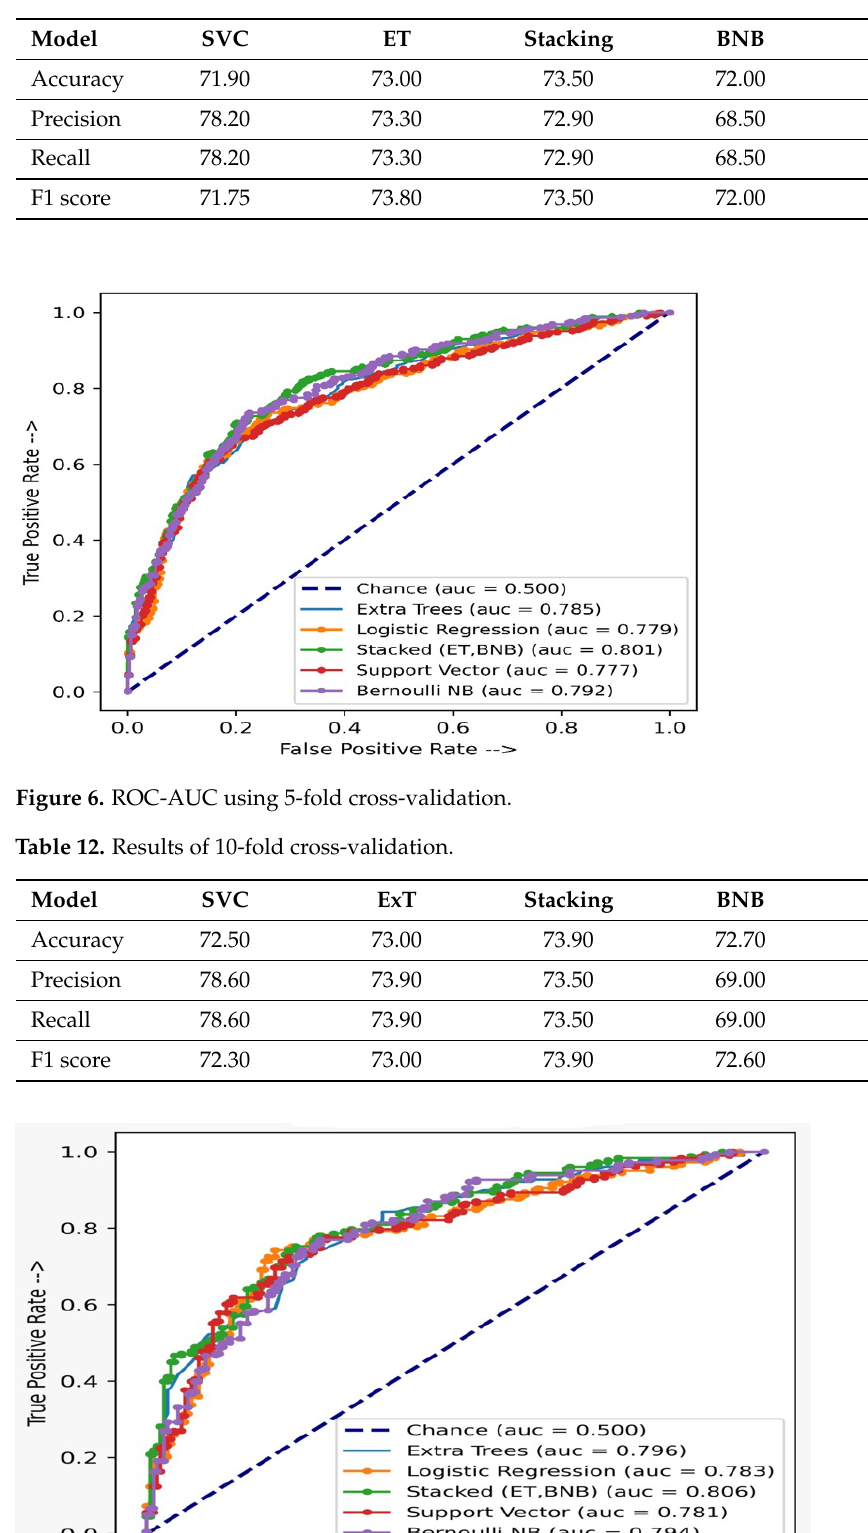
Table 11. Results of 5-fold cross-validation.